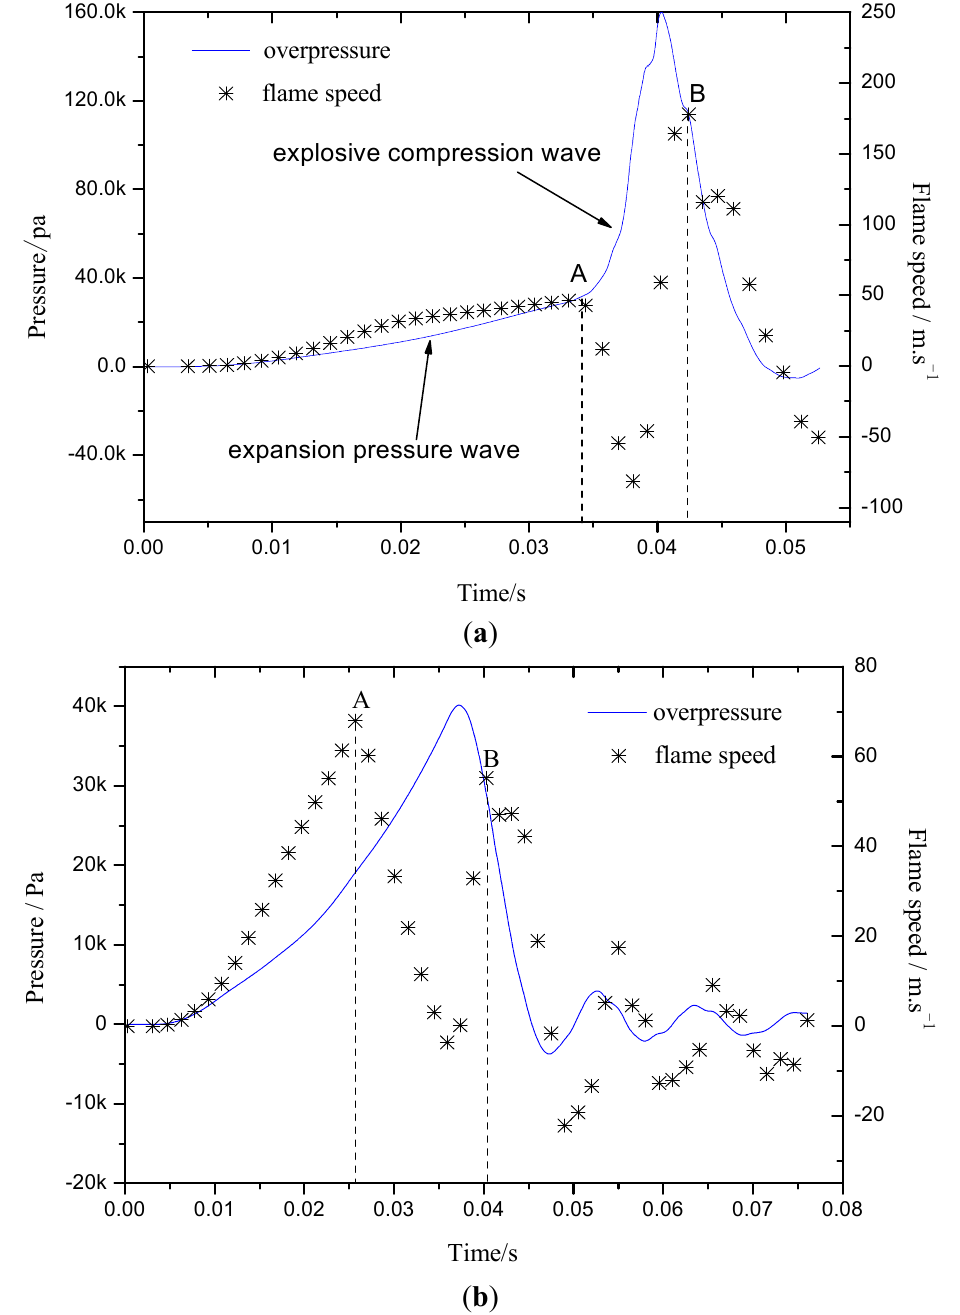
Figure 2. Relationship between flame speed and pressure with time: ( a ) volume concentration: 11%; ( b ) volume concentration: 9.5%; ( c ) volume concentration: